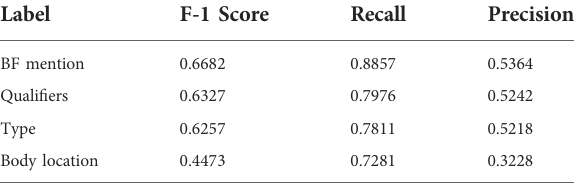
TABLE 5 Entity-based body function evaluation (test sample).